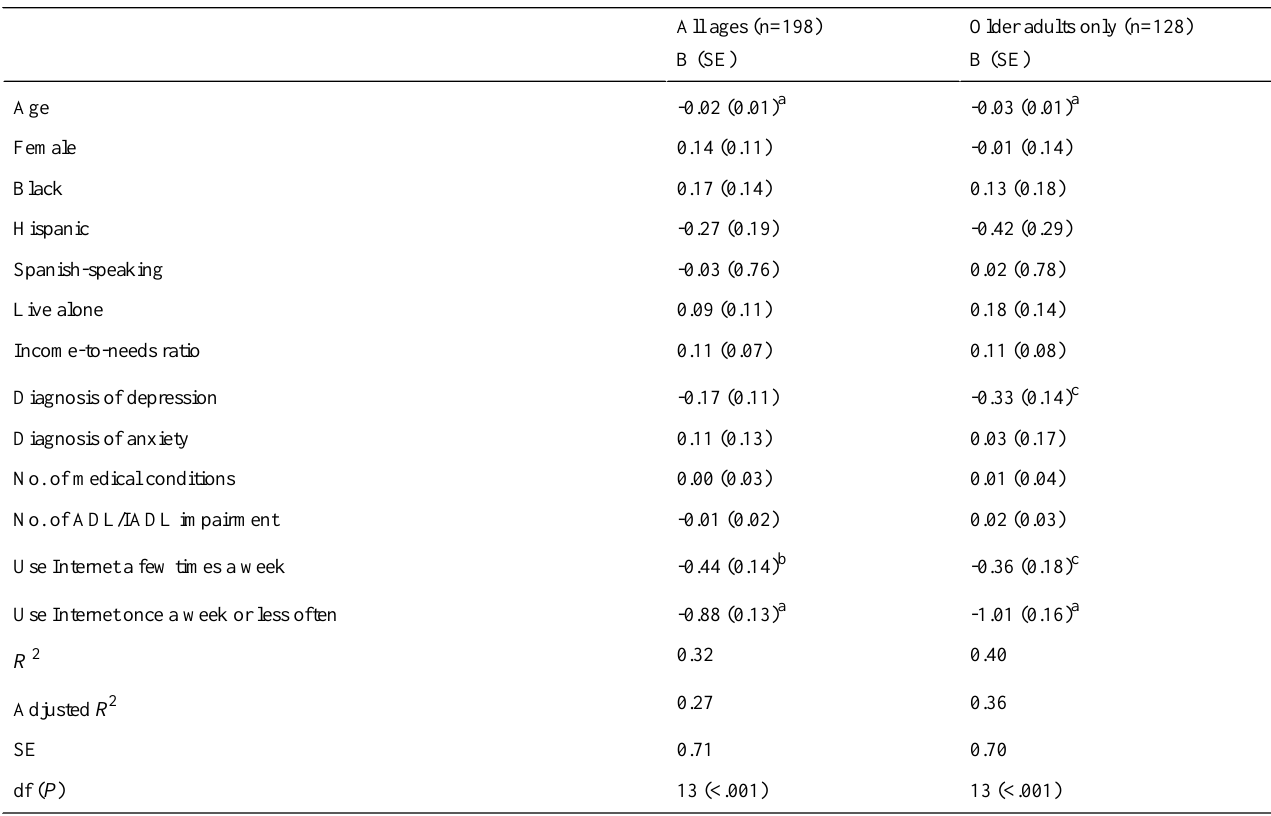
Table 6. Correlates of eHEALS among current Internet